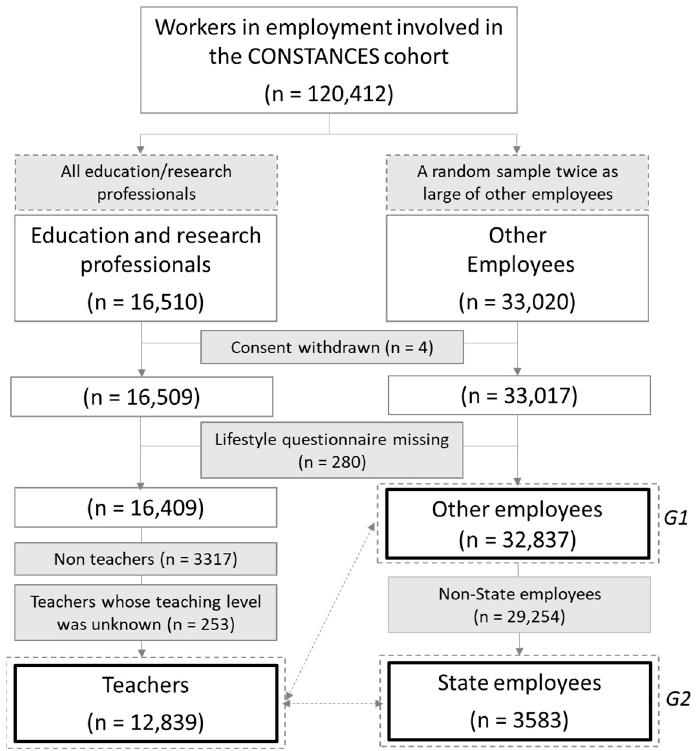
Figure 1. Flowchart of the study population.